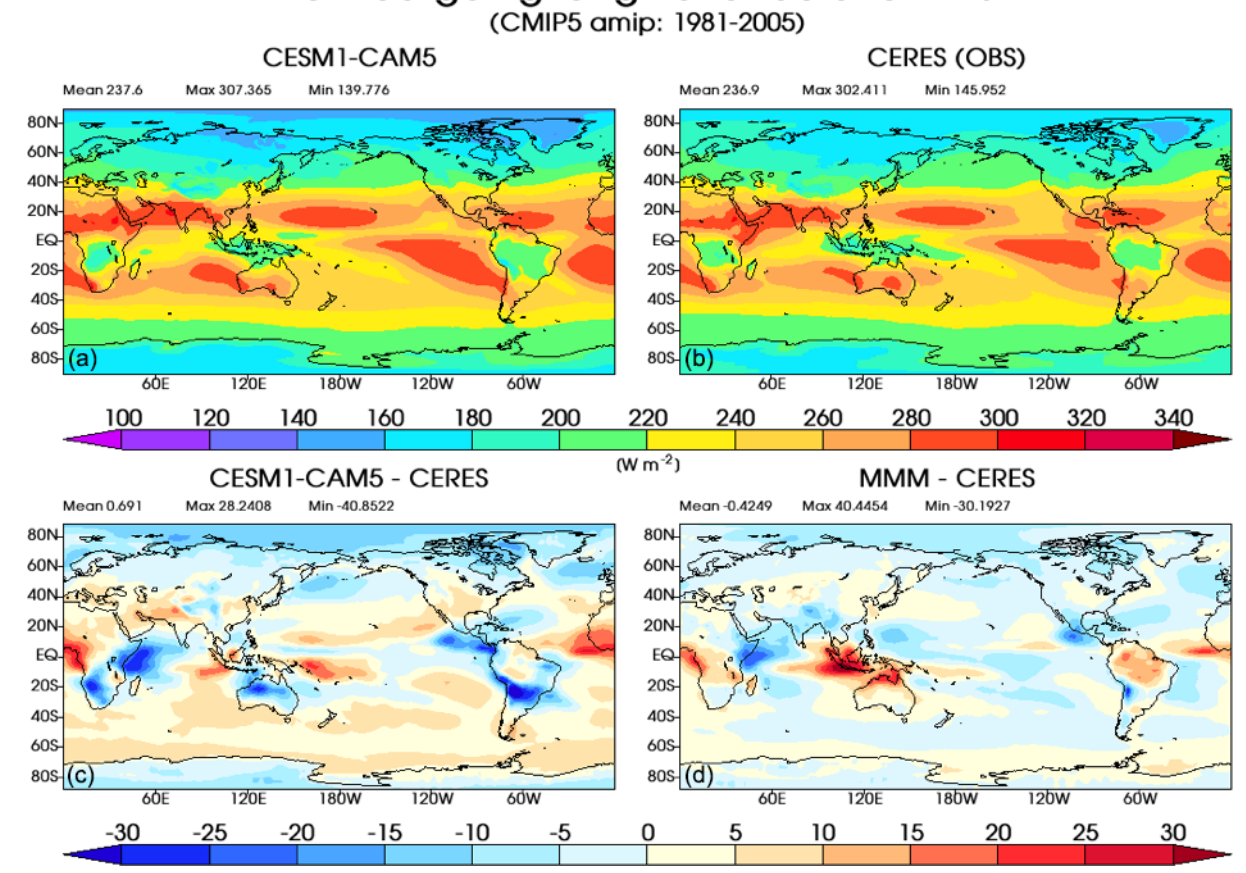
Figure 3. An illustration of a model–observation comparison using obs4MIPs datasets. This four panel figure shows December–January– February (DJF) climatological mean (1981–2005) results for an individual model (a) , the CERES-4-0 EBAF dataset (b) , a difference map of the two upper panels (c) and a difference between the CMIP5 multi-model-mean (MMM) and CERES observations (d) . The averaging period of the CERES-4-0 DJF mean is 2005–2018 (units are Wm − 2